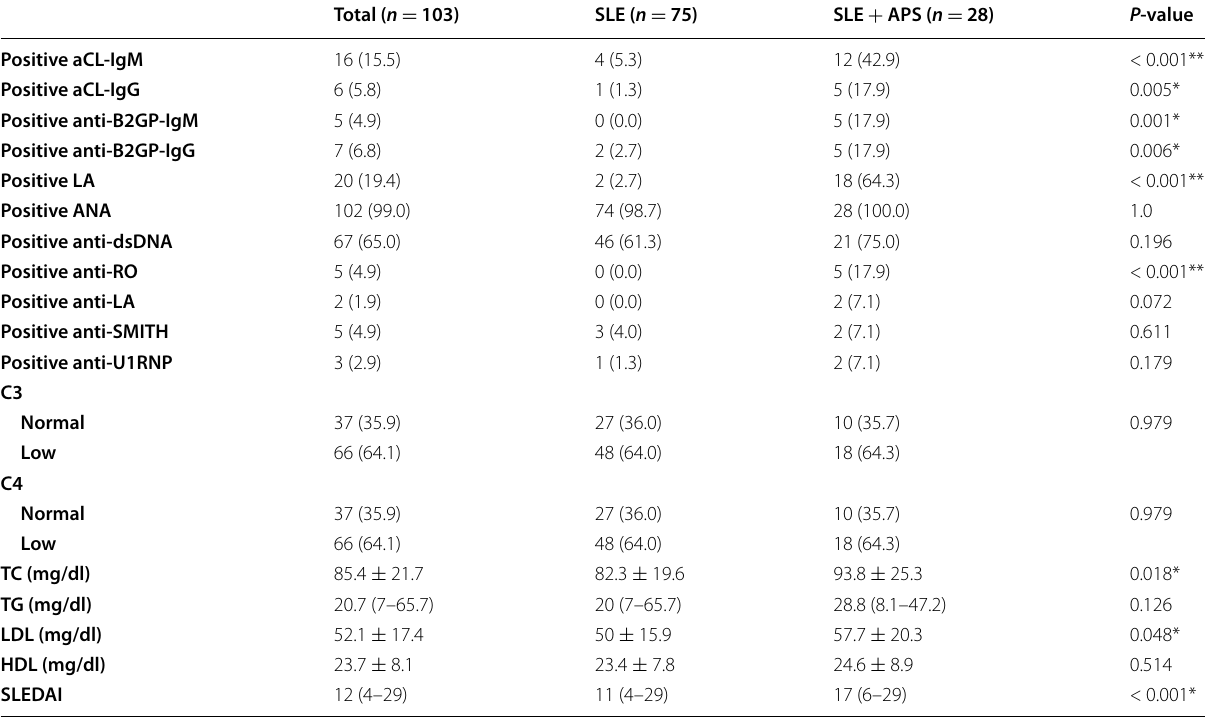
Table 4 Laboratory findings and disease activity of SLE patients with and without APS